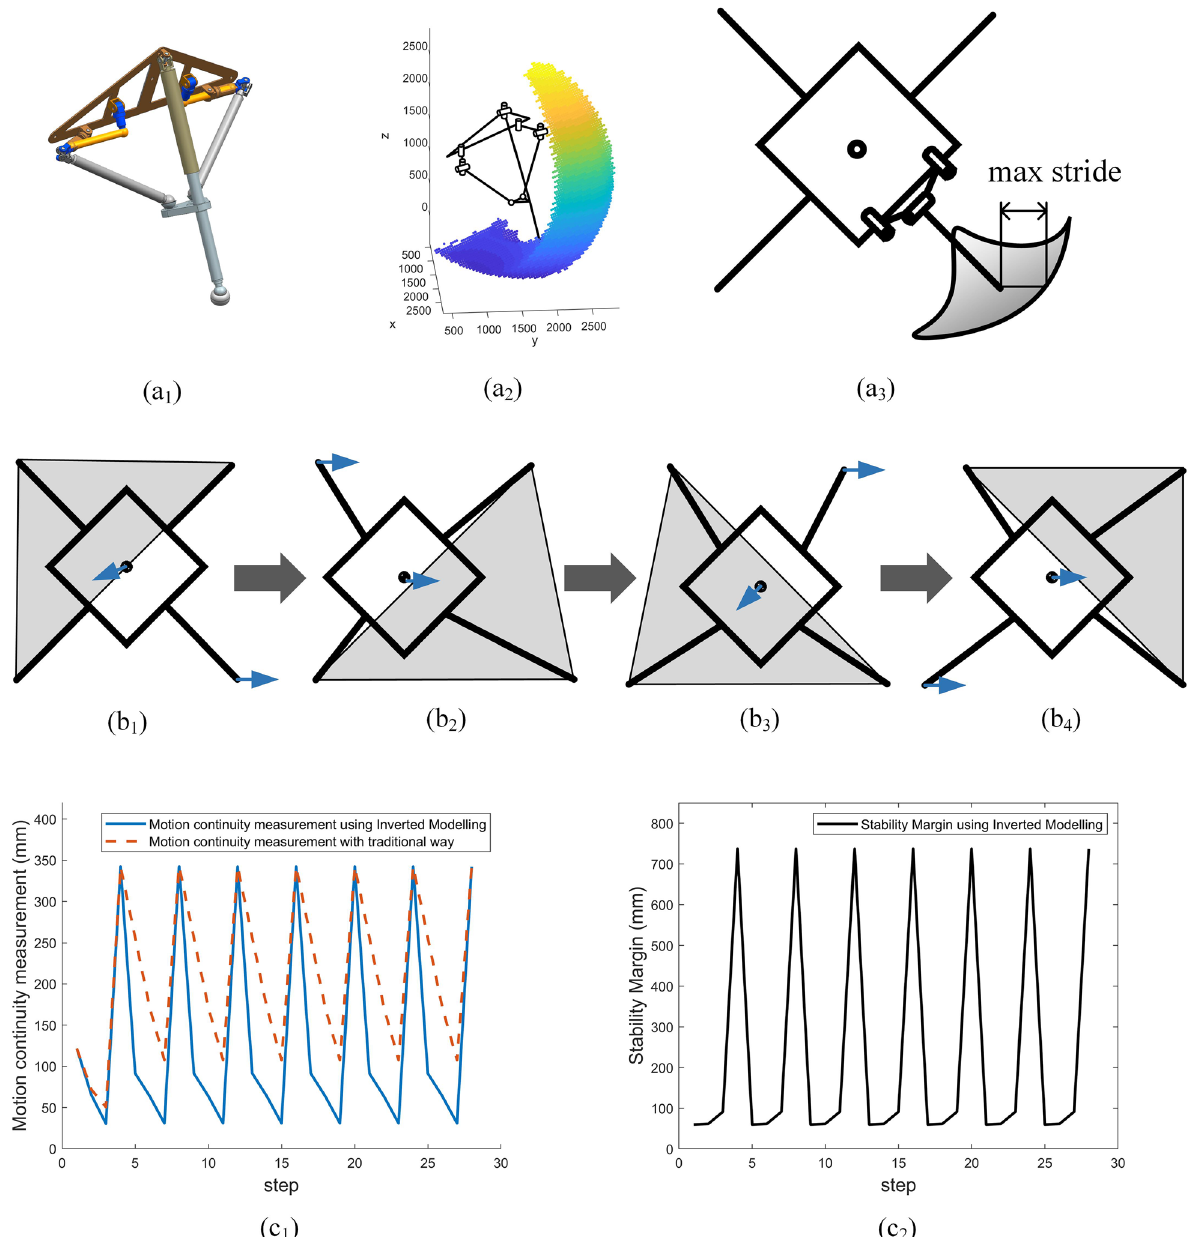
Figure 10 Quadruped robot walking with free gait: a 1 UP-2-RUS-4R quadruped robot leg mechanism model, a 2 UP-2-RUS-4R leg mechanism workspace,